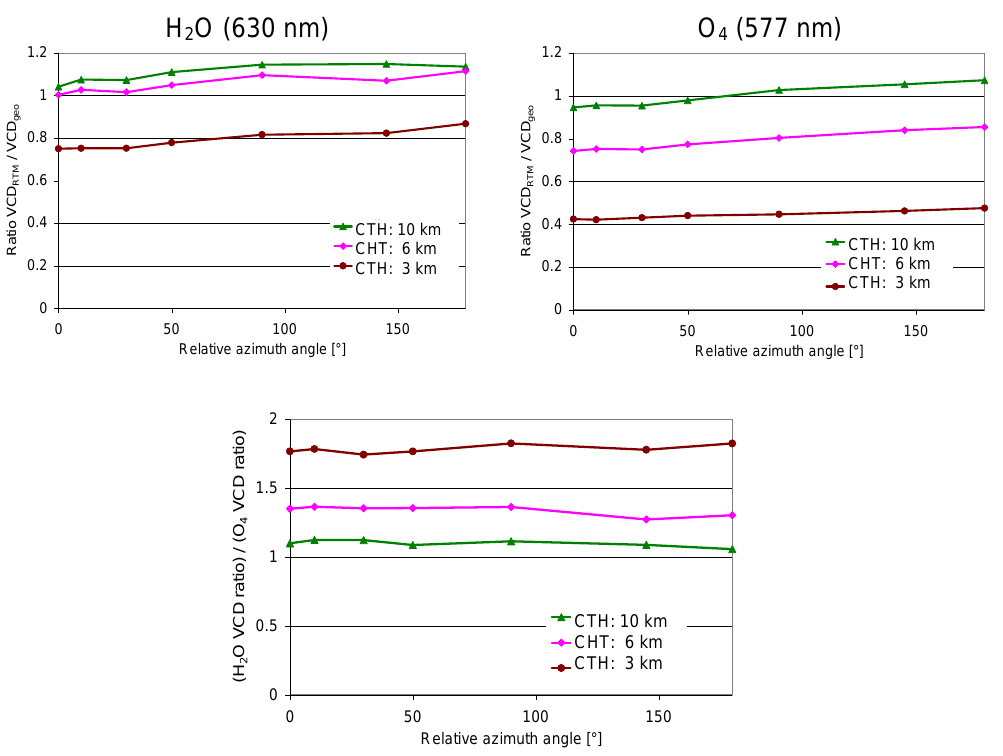
Fig. 8 Diffusing screen effect of clouds on the retrieval of the H O VCD (top left) and the O 2 4 Fig. 8. Diffusing screen effect of clouds on the retrieval of the H 2 O VCD (top left) and the O 4 VCD (top right) determined by the geometric VCD (top right) determined by the geometric approximation as a function of the relative approximation as a function of the relative azimuth angle. Bottom: ratio of the diffusing screen effect for H 2 O and O 4 . The radiative transfer azimuth angle. Bottom: Ratio of the diffusing screen effect for H O and O . The radiative 2 4 simulations were performed for a SZA of 50 ◦ . The cloud optical and vertical thicknesses were set to 5 and 1km, respectively. transfer simulations were performed for a SZA of 50°. The cloud optical and vertical 29 thicknesses were set to 5 and 1 km, respectively. Variation of high-pass filtered R for successive